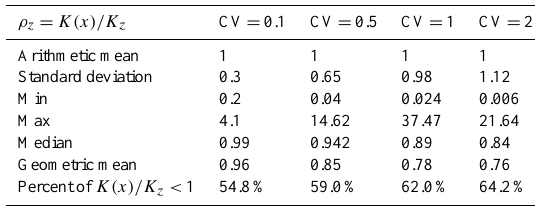
Table 1. Grid-scale K field